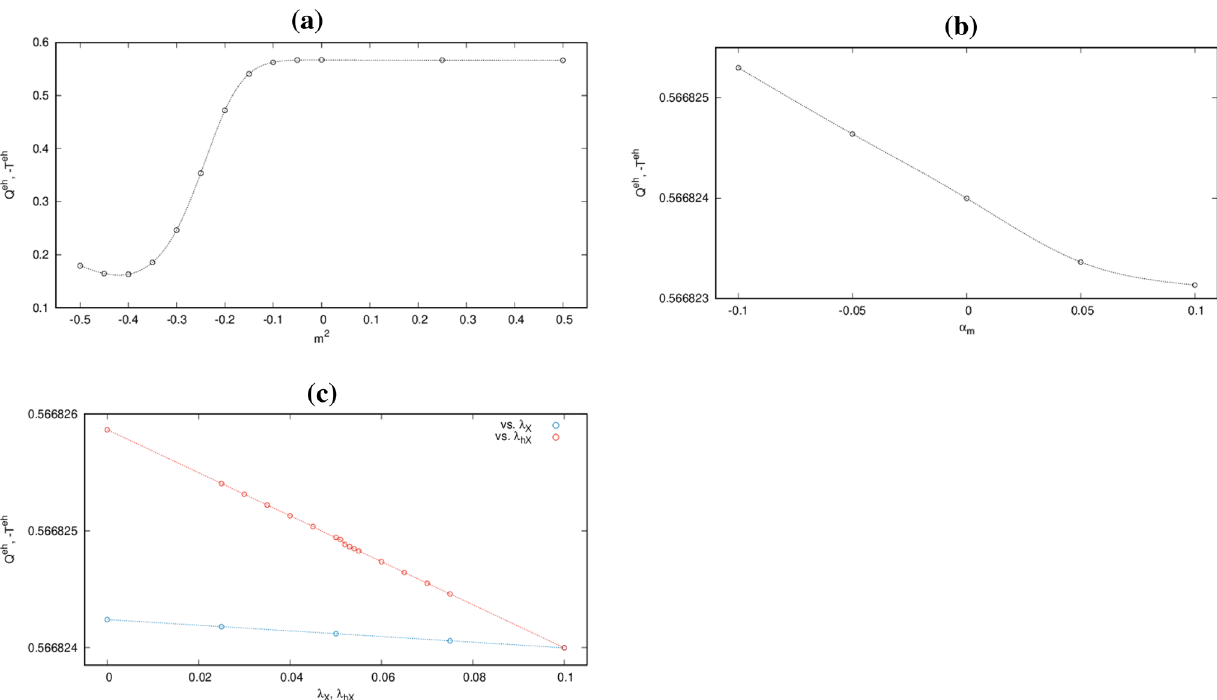
Fig. 4 The black hole charges related to the U ( 1 ) gauge fields, Q eh and T eh , as functions of a m 2 , b α m and c λ X ,λ hX , for evolutions with scalars minimally coupled to gravity and non-varying parameters as in Fig. 3 r = 0 surrounded by an apparent horizon that is either space- like or null, when situated along a u = const .